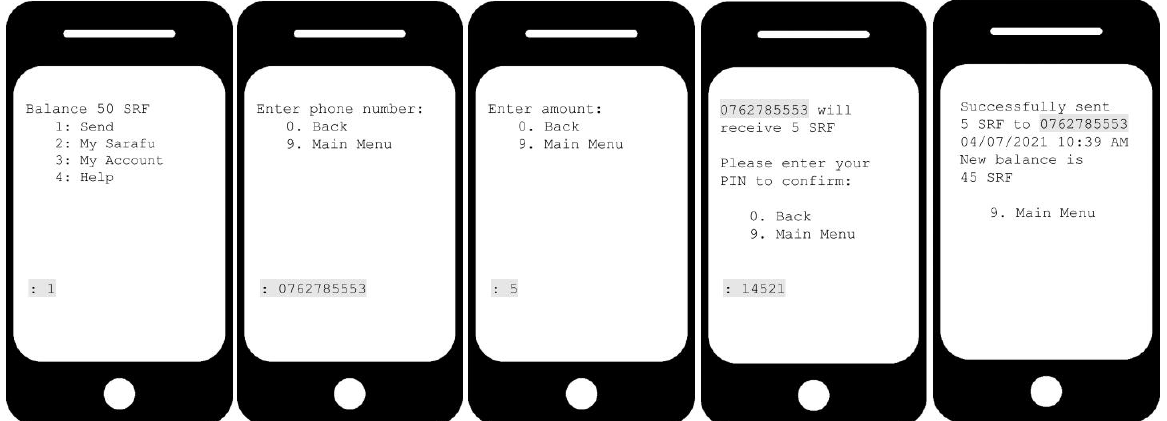
Figure 2. The 2020-21 Sarafu Network Mobile Phone Menus. The network allows trading CCs without an Internet connection. This example shows a user sending five Sarafu tokens to another user, after which both parties would receive a receipt SMS for the transaction. A similar menu was used from 2018–2019 although at that time it was a community token (either Bangla, Miyani, Zeni, Gatina etc) not Sarafu that was transferred by standard individual account holders.